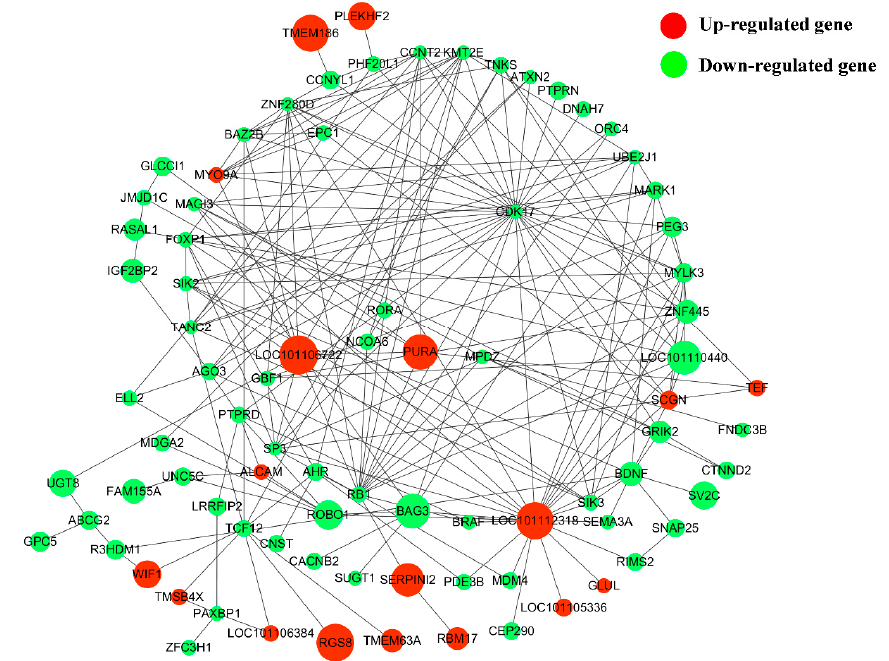
Figure 5. The network of 87 screened DE genes enriched for Hu sheep pituitary functions and reproduction related pathways were constructed, the red and green circular represent upregulated and downregulated DE genes, respectively. Node size represents the fold change of a node. Information about genes is shown in Table S6.